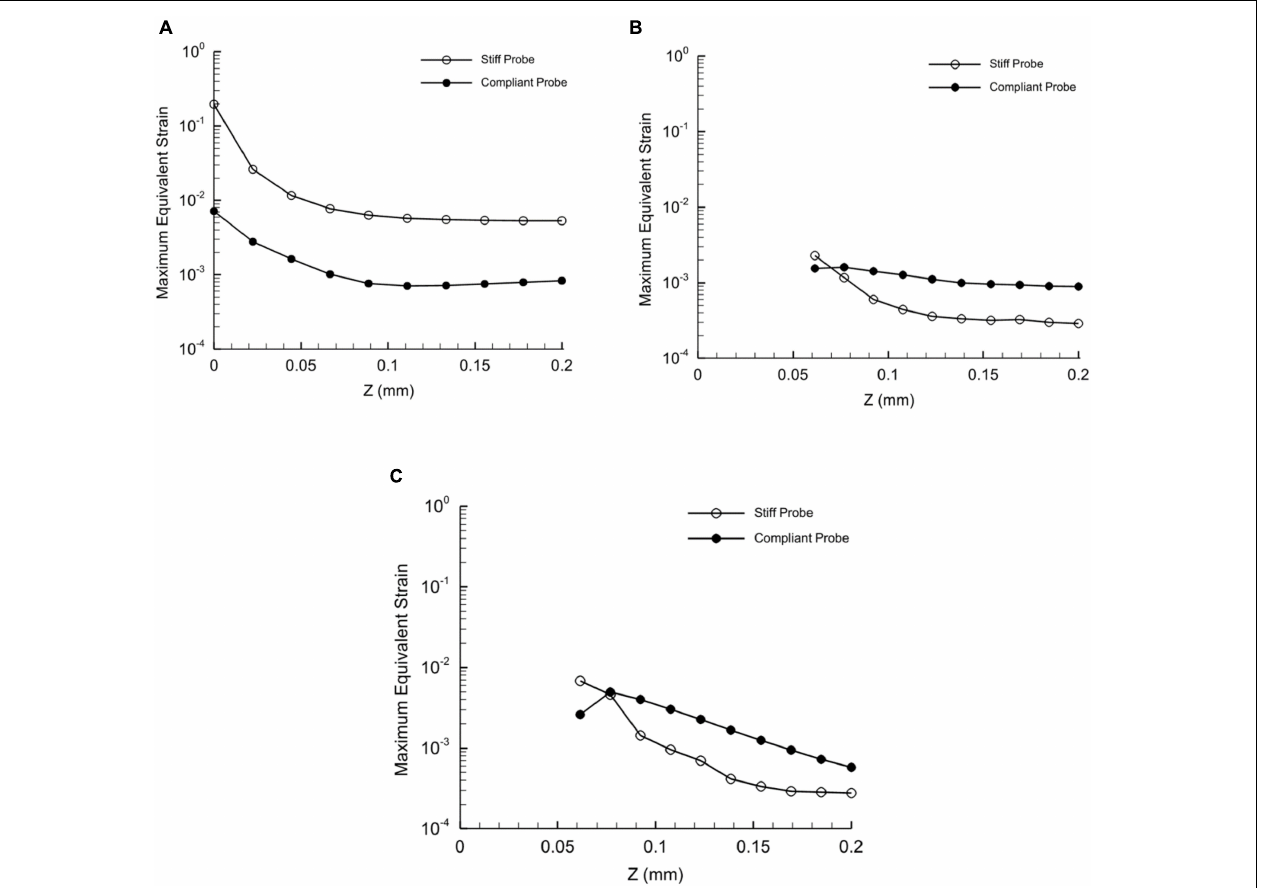
FIGURE 9 | Distribution of the maximum equivalent strain of stiff and compliant probes with respect to distance in Z -axis direction at three different heights. (A) Tip of the probe; (B) mid of the probe; (C) top of the probe. The displacement applied on the two probes is 20 µ m – Case 3 and 8 in Table 1 . Since the thickness of the probe differs with height, the predictions in the plot (B,C) start at 62.5 µ m from the probe axial axis. Refer to Figures 2 , 3 for the height locations. Note that the Y -axis values are set to log scale.